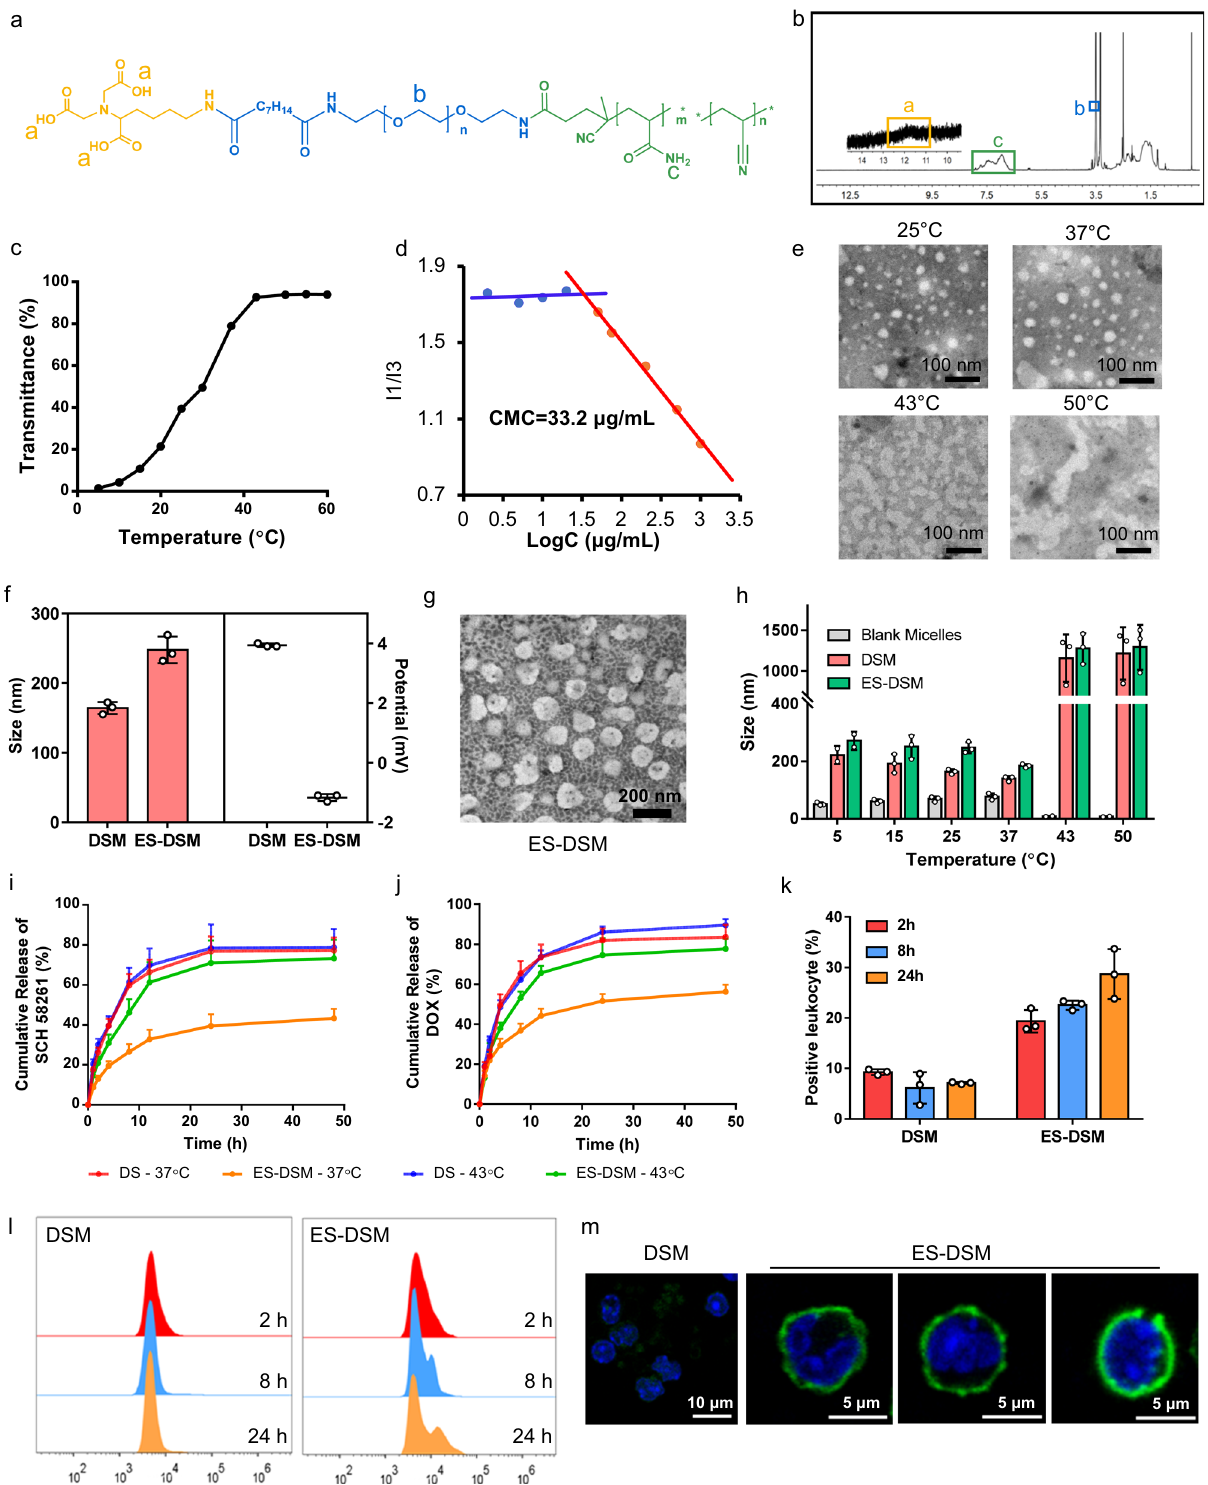
Cellular drug release, cytotoxicity, and ICD induction ability of ES-DSM supplemented with hyperthermia . Next, the thermal- sensitive drug release behavior at the cellular level was investi- gated by confocal microscopy. First, Nile red was used as the model drug to prepare Nile red-loaded micelles. When 4T1 cells were exposed to Nile red-loaded micelles and treated with